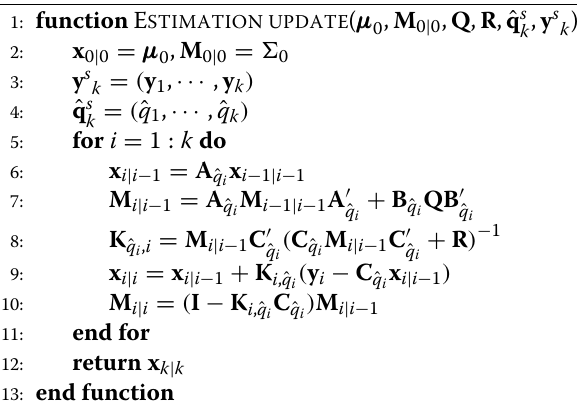
Algorithm 1 Mode-based Kalman